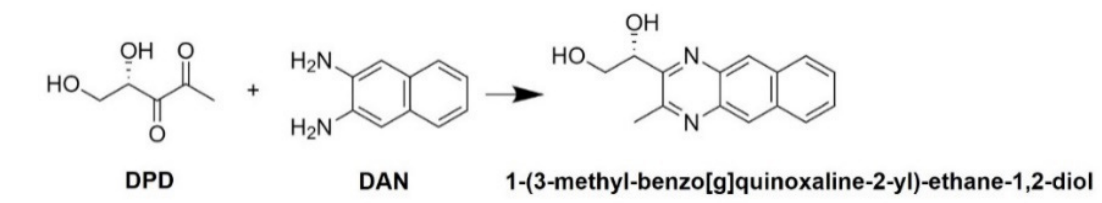
Figure 1. Product of the reaction of ( S )-4,5-dihydroxy-2,3-pentandione (DPD) with 2,3-diaminonaphthalene (DAN). The reaction mixture was eluted using an HPLC with a UV detector at a wavelength of 225 nm (Figure 2a). The second peak, appearing at a retention time of 1.5 min, corresponded to DAN. The third peak at a retention time of approximately 3 min corresponded to the derivative of DPD and DAN. The structure of the derivative shown in Figure 2a was confirmed by mass spectrometry (Figure S2). The eluted sample corresponding to the derivative was further scanned using a UV spectrometer in the range of 200–380 nm. The derivative showed specific absorption peaks at 225, 268, and 365 nm (Figure 2b). As the peak at 268 nm gave the highest intensity, it was adopted for the subsequent analysis of the